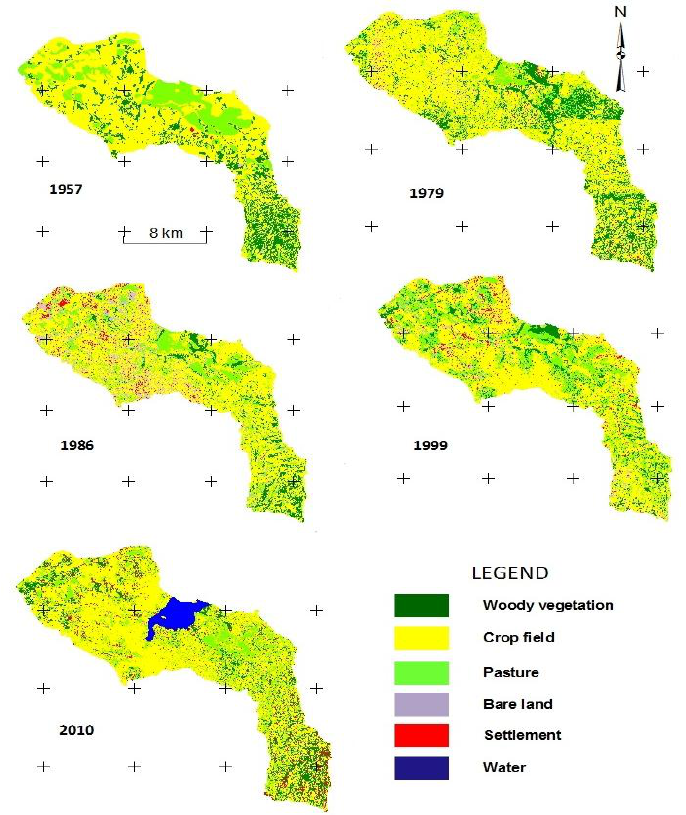
Figure 5. Land use/cover map of the Koga